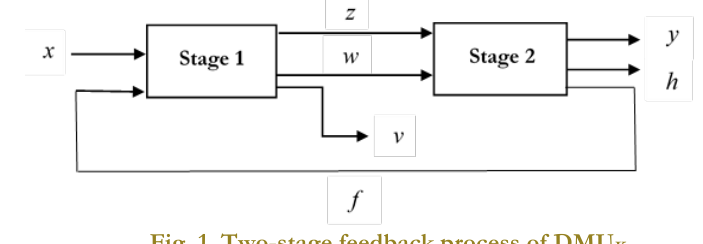
Fig. 1. Two-stage feedback process of DMU K